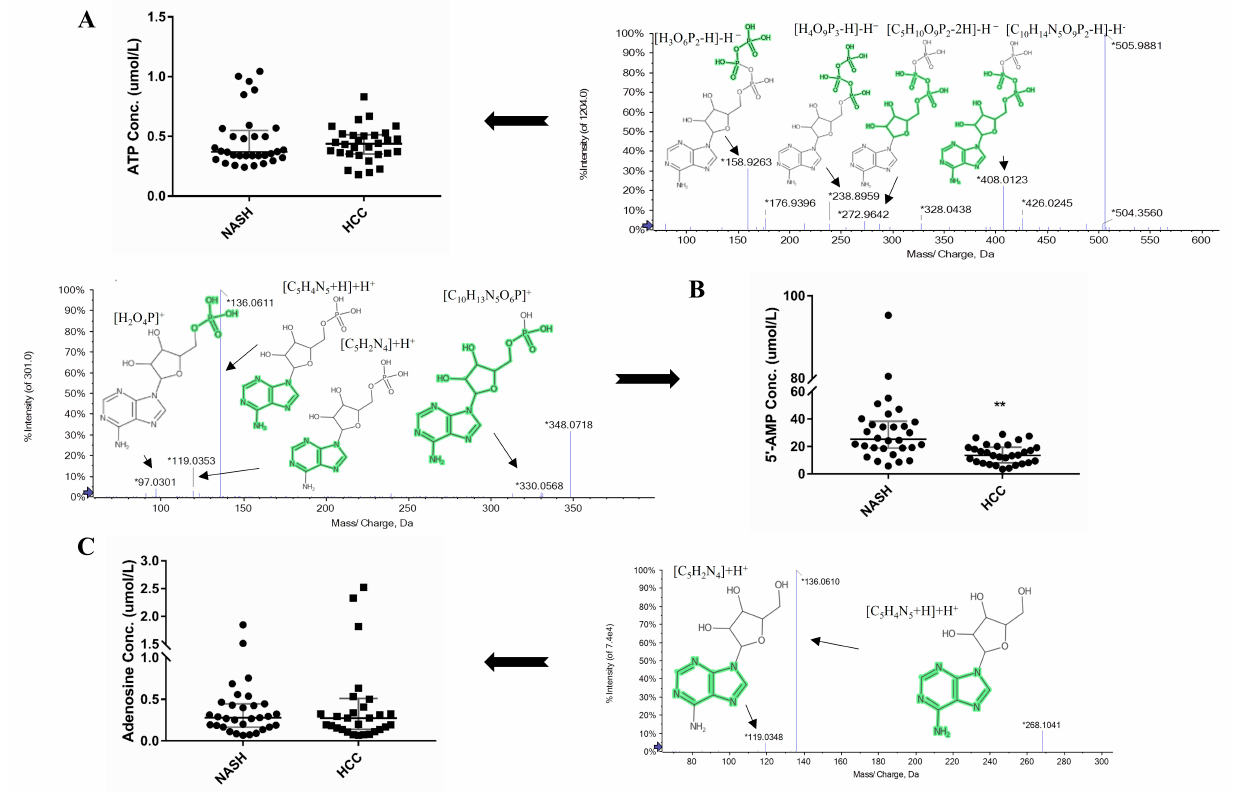
Figure 5. Quantification of ( A ) ATP, ( B ) 5 ′ -AMP, and ( C ) adenosine in NASH and NASH-HCC patients with fragmentation pattern for each compound. ** p < 0.01 in the boxplot.